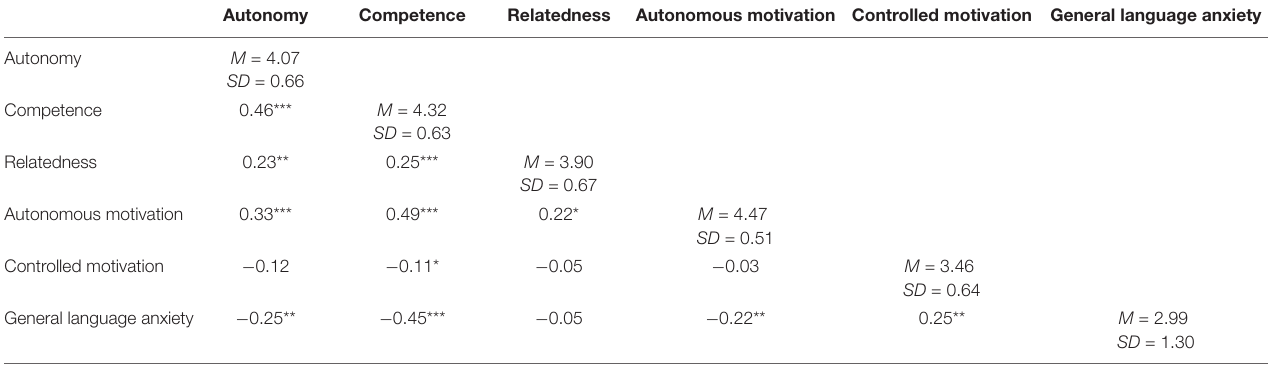
TABLE 1 | Means, standard deviations, and zero-order correlations Spearman’s rho ( ρ ) between the